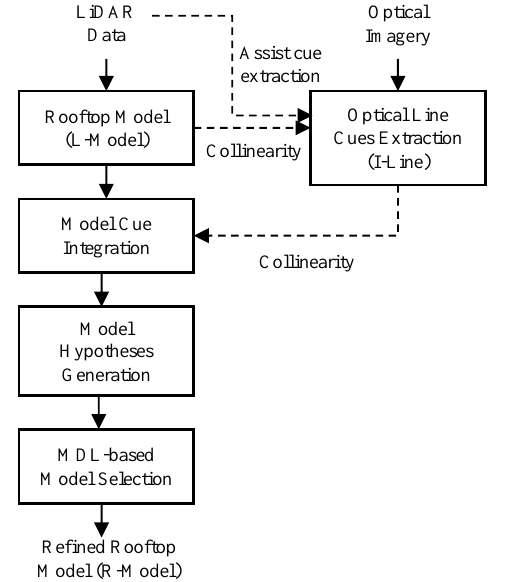
Figure 1 . The overall workflow of proposed sequential modelling